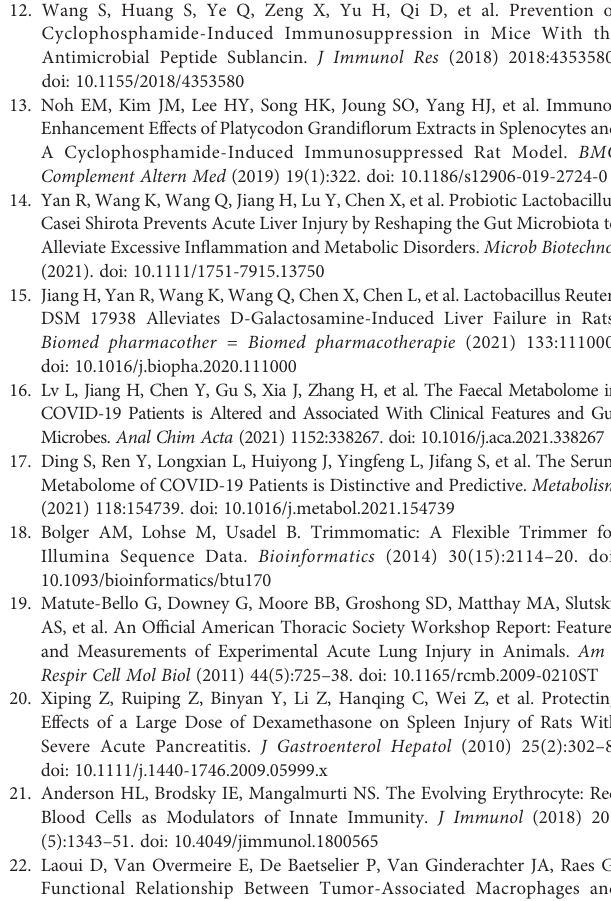
Supplementary Figure 1 | Representative changes in gene transcription in the colonandspleenveri fi edbyRT-qPCR. (A) Relativeexpressionof Tlr4 and Tlr5 inthe colon. (B) Relative expression of Nf- k b and Tjp1 in the spleen. (*P < 0.05; **P <